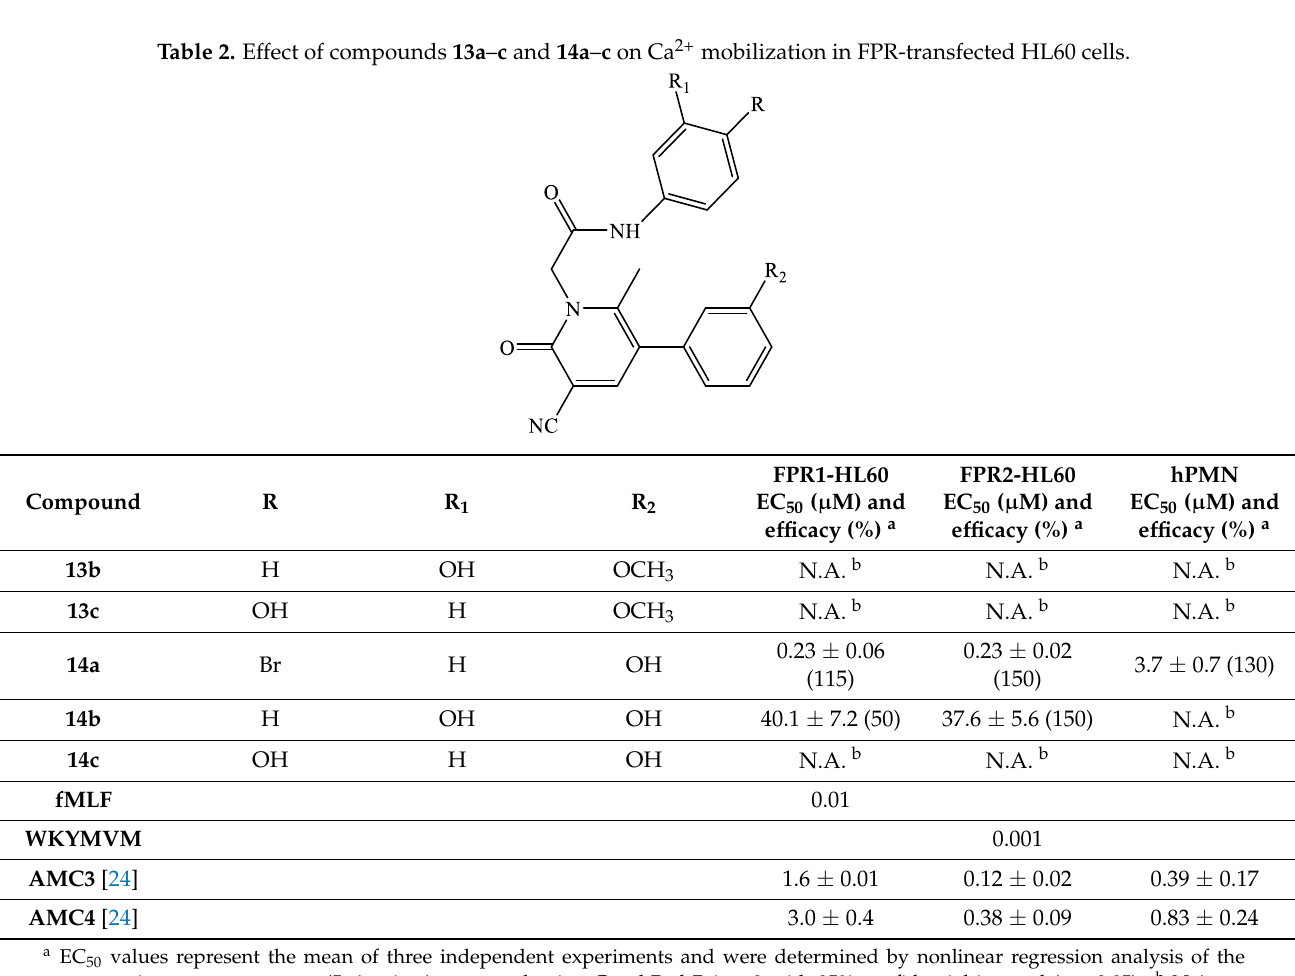
Table 2. Effect of compounds 13a – c and 14a – c on Ca 2+ mobilization in FPR-transfected HL60 cells.